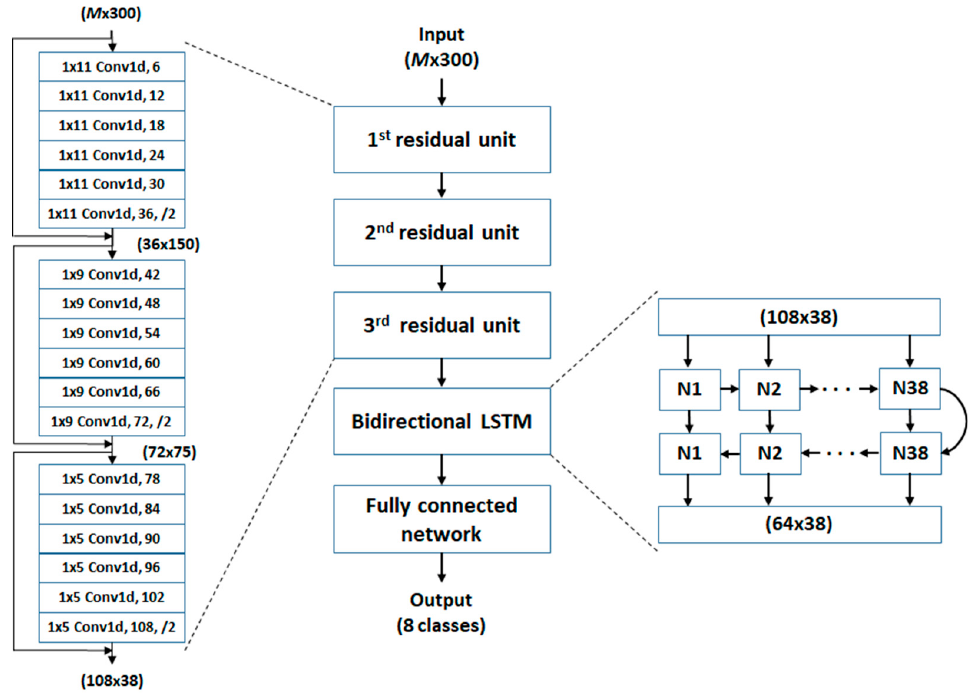
Figure 4. Deep neural network for detecting fall and 7 types of physical activities based on foot pressures and foot inertial data ( M channels). Table 3. Deep residual network